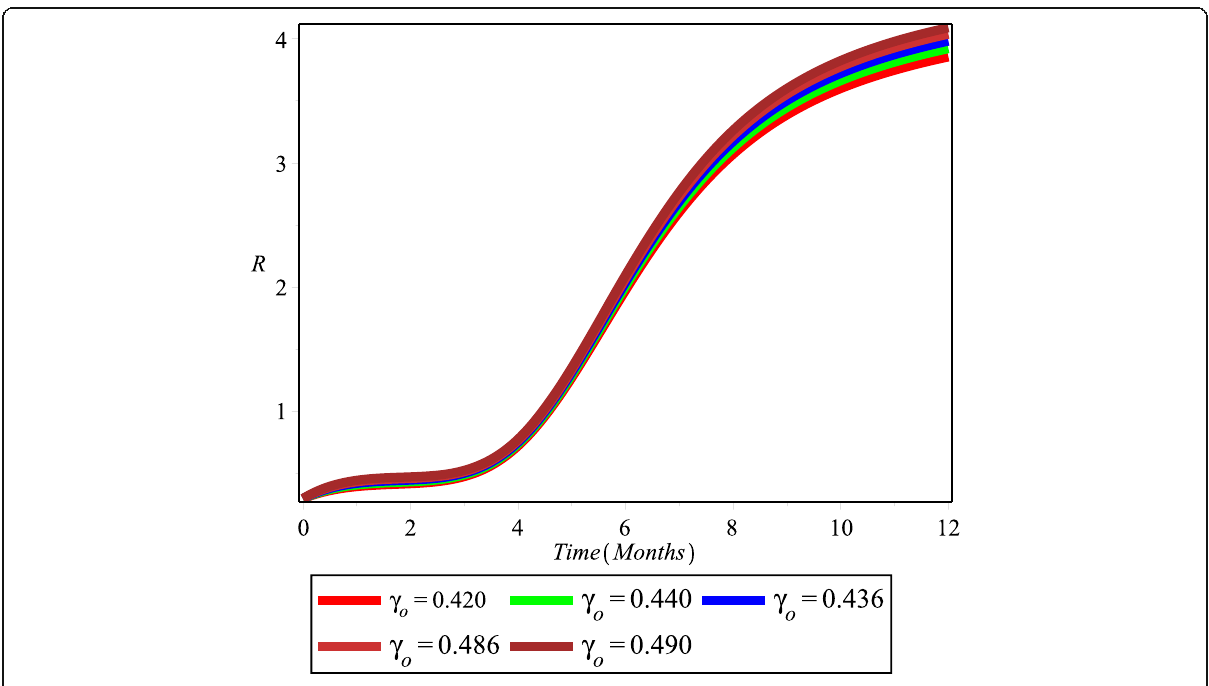
Fig. 6 Varying γ 1 (0.100 − 0.164) when R r <